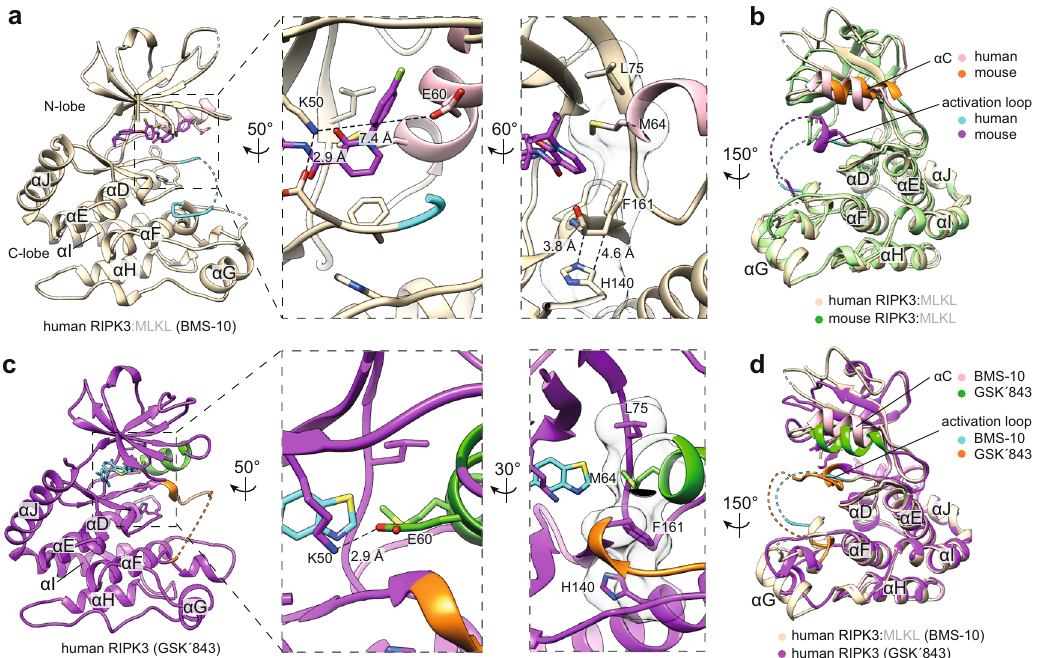
Fig. 3 Human RIPK3 exhibits conformational plasticity. a Human RIPK3 (wheat) from the complex with MLKL adopts an inactive conformation. Zoomed panels highlight the disrupted K50-E60 salt bridge (shown as sticks; center panel) and partial alignment of R-spine residues (shown as sticks and transparent surfaces; right panel). The α C helix (pink), activation loop (cyan), and Compound 10 (magenta sticks) are highlighted. b Superimposition of human (wheat; this study) and mouse (blue; PDB: 4M69) 46 RIPK3 kinase domains from their respective complexes with MLKL. Electron density was not observed for part of the activation loop, which is signi fi ed by a dashed line. c Structure of human RIPK3 bound to the Type I inhibitor, GSK ′ 843 (this study; PDB: 7MX3). The K50-E60 salt bridge interaction is shown in the middle panel as a dashed line. The R-spine residues are shown in the right panel as sticks and a surface. The α C helix (green), activation loop (orange), and GSK´843 (cyan sticks) are highlighted. d Superimposition of human RIPK3 from the MLKL complex (PDB: 7MON; wheat) and bound to GSK ′ 843 (PDB: 7MX3;